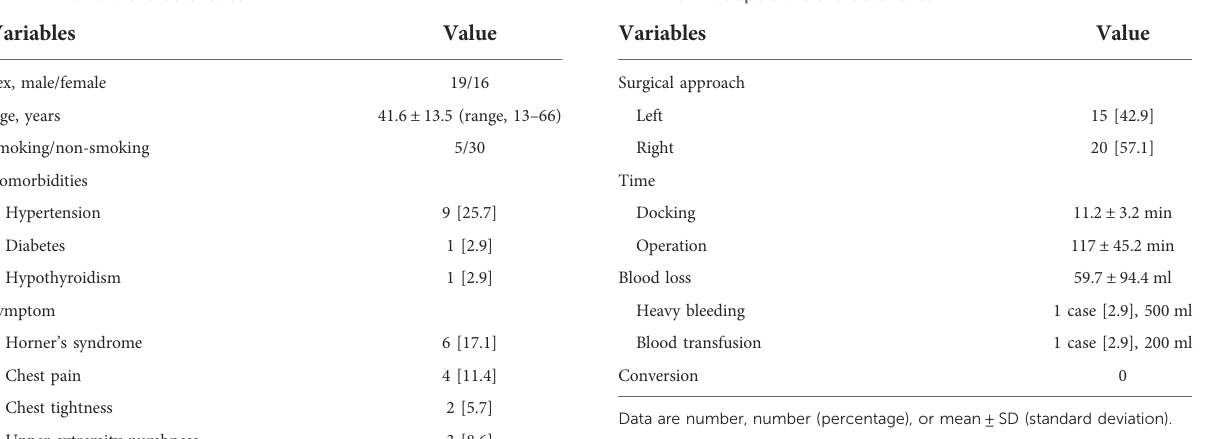
TABLE 3 Intraoperative characteristics.